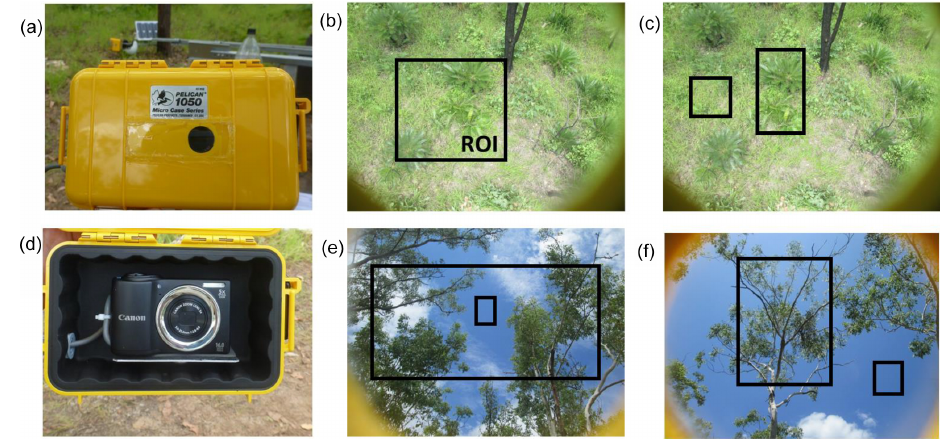
Figure 2. Camera setup (a, d) and examples of understory (b, c) and overstory (e, f) regions of interest (ROI, black box) used from phenocam images collected at the Howard Springs OzFlux